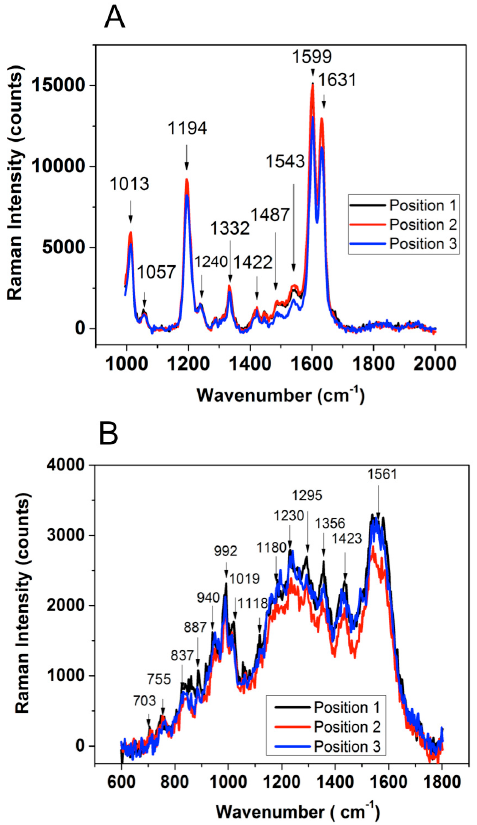
Figure 7. SERS spectra of adsorbed BPE ( A ) and Cyt-B5 ( B ) molecules onto sample 2.